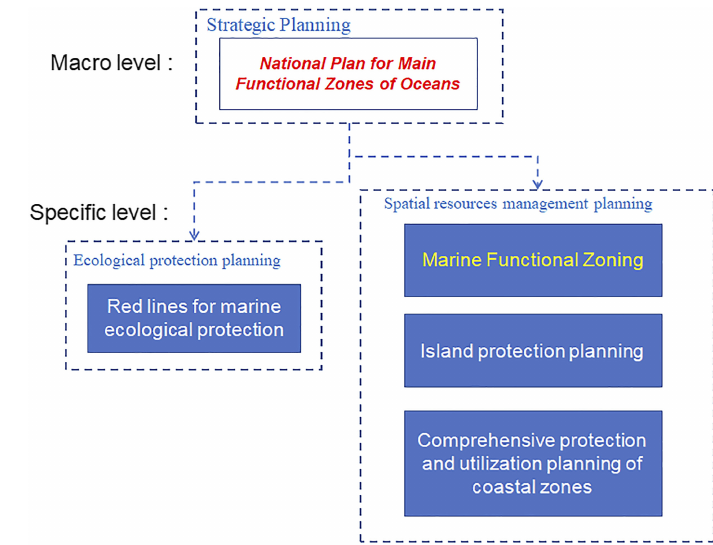
Figure 1. Marine spatial planning system of